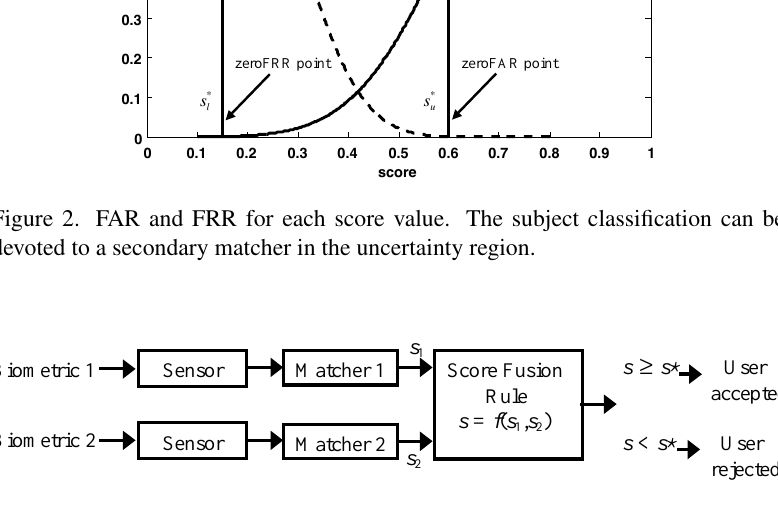
Figure 3. The outline of the multimodal biometric system in parallel fusion